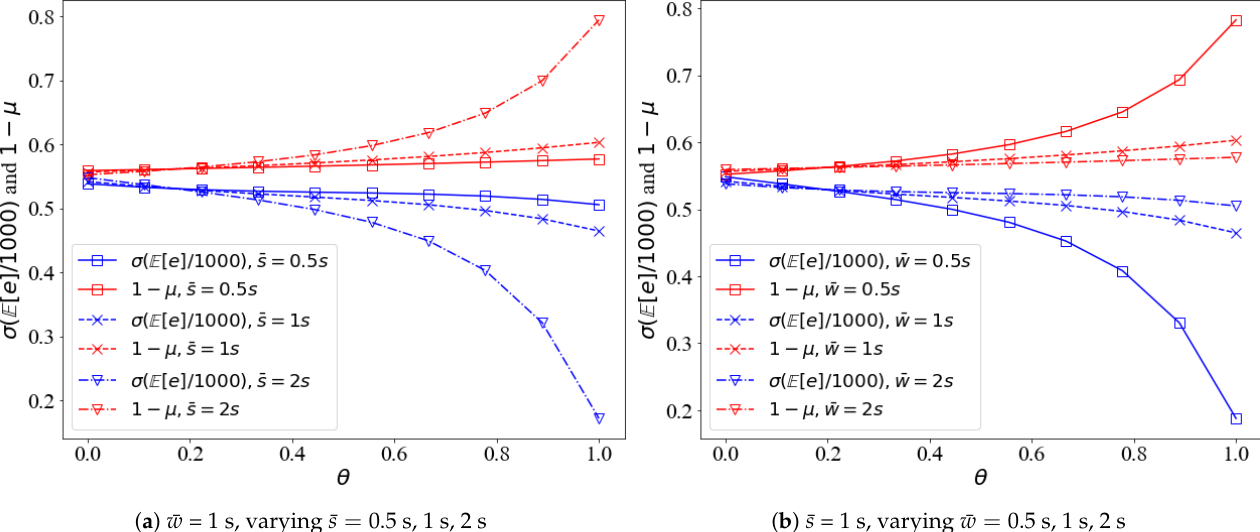
Figure 11. The detection accuracy and energy depletion against θ . ( a ) ¯ w is fixed to 1 s, varying ¯ s ; ( b ) ¯ s is fixed to 1 s, varying ¯ w